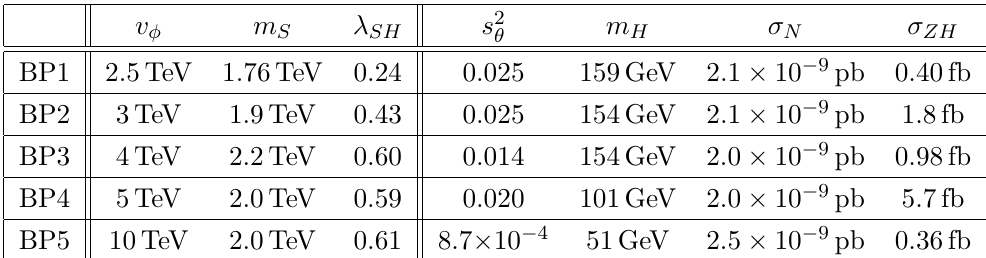
Table 2 . Benchmark points (BPs) satisfying the DM relic abundance, the bounds from the DM direct search, and the perturbativity in CP 2-2. For each point, we show the predictions of s 2 the mass of H , DM scattering cross section with nuclei σ N , and the production cross section √ e + e − → ZH at the ILC with s = 250